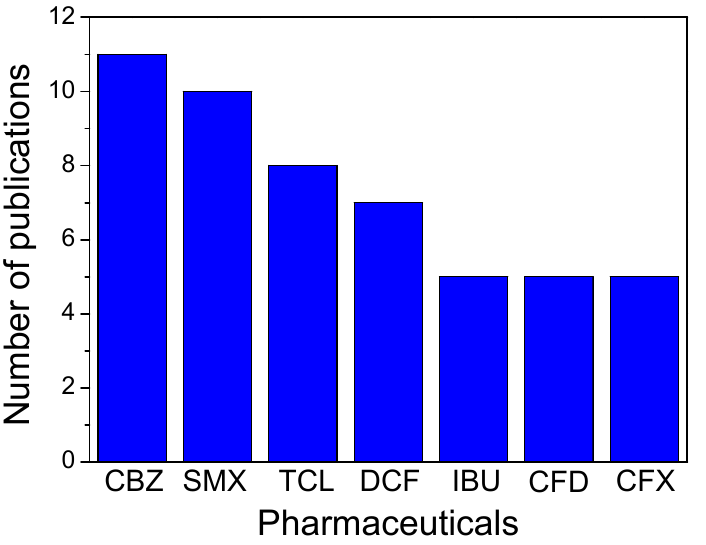
Figure 2. Number of publications of the most studied PhCs as it concerns their removal using EOPs during the last decade.